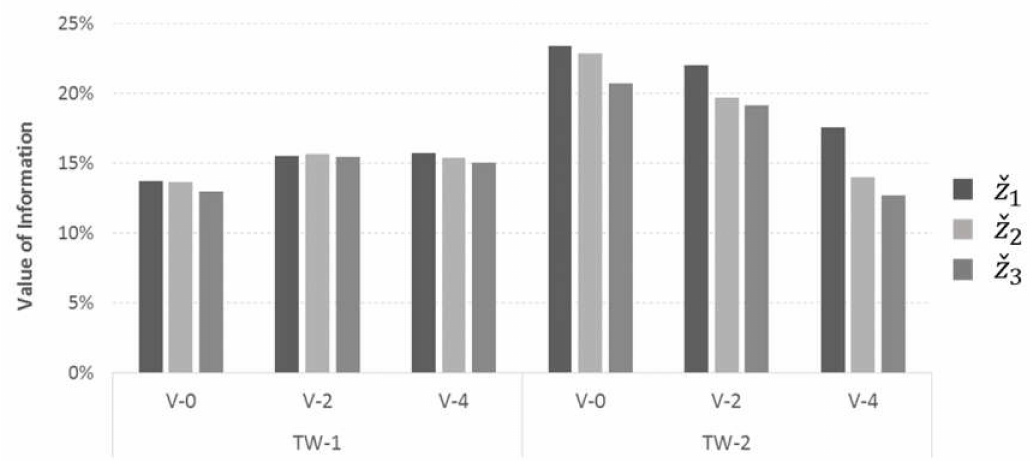
Figure 8. Average performance of objectives for di ff erent TW pattern groups and fleet availability values (V-0, V-2 and V-4 refer to small, medium and high vehicle availability as per Figure 4; TW-1 and TW-2 refer to the TW width as per Table